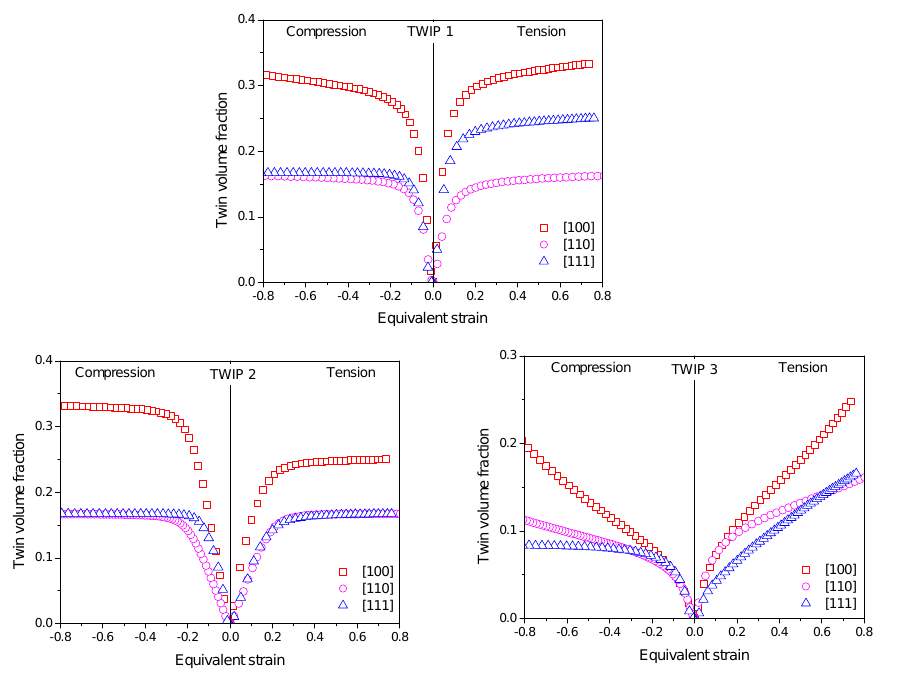
Figure 12. Twin volume fraction of a single crystal of TWIP steels subjected to tension and